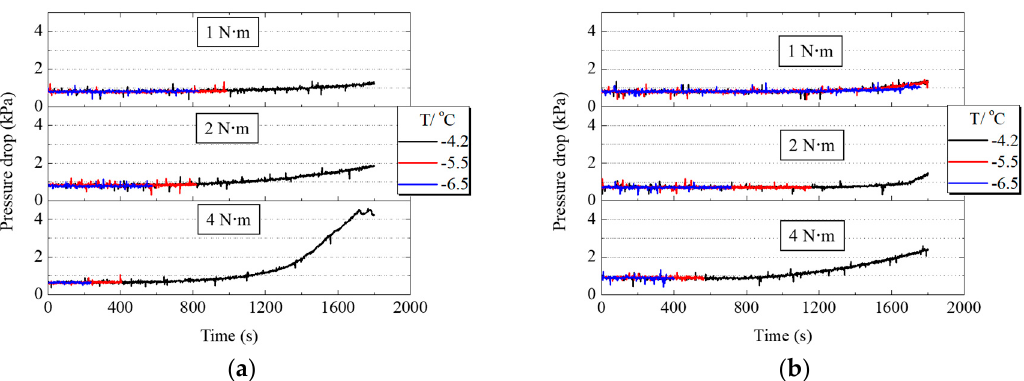
Figure 7. Pressure drop variation of PEMFC with C-MPL & GDL and H-MPL & C-GDL under different assembly pressures: ( a ) Pressure drop changes of PEMFC with C-MPL & GDL; ( b ) Pressure drop changes of PEMFC with H-MPL & C-GDL.